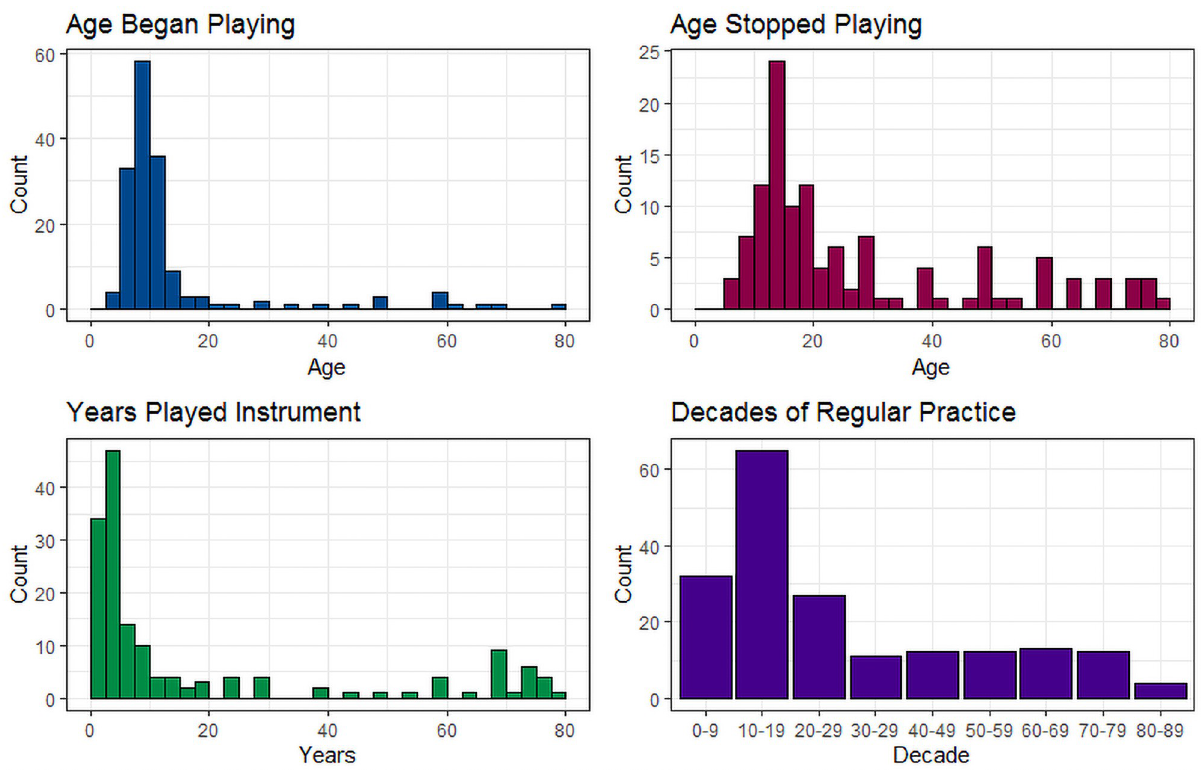
Fig 2. Responses to Section 1 of the ELMEQ: Musical instruments.